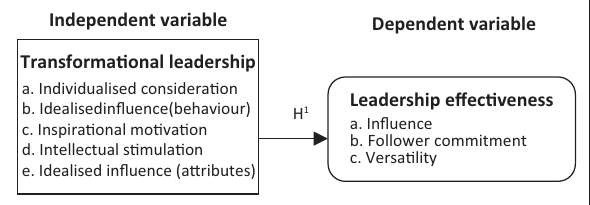
FIGURE 2: The revised hypothesised mode of the relationship between transformational leadership and leadership